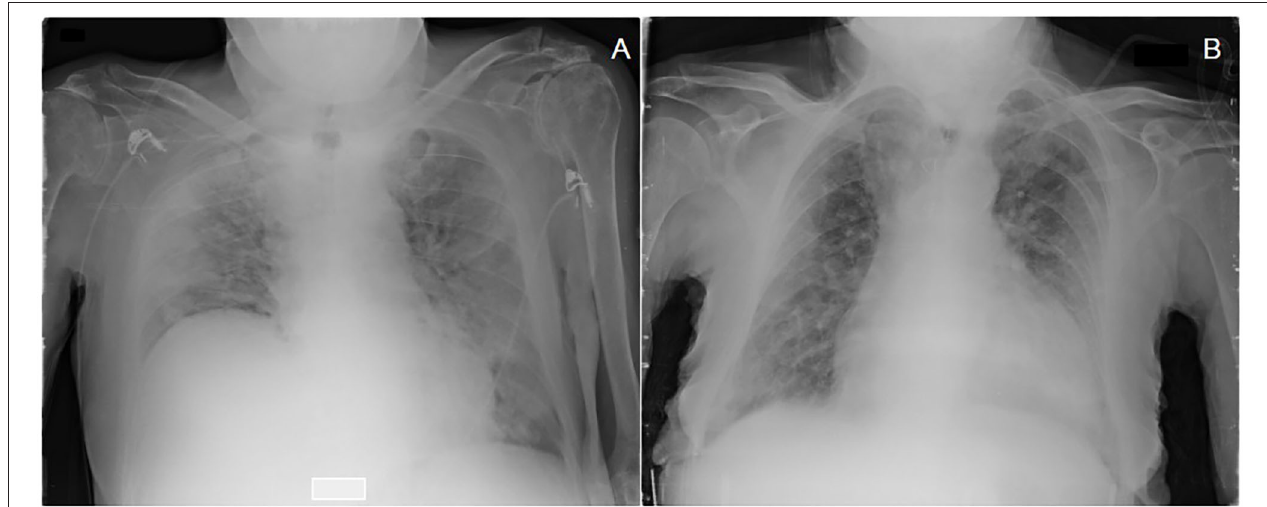
FIGURE 1 | Chest X-ray with a high CARE score at admission of two patients treated with high intensity medical care (HIMC) during hospitalization and with different values of viral load (Gene E) at diagnosis: (A) a 81 years old patient presenting a CARE score of 22 points and a viral load of 2.43 log10 copies/ml ( < 25th percentile); (B) a 92 years old patient presenting a CARE score of 18 points and a viral load of 6.72 log10 copies/ml ( > 75th